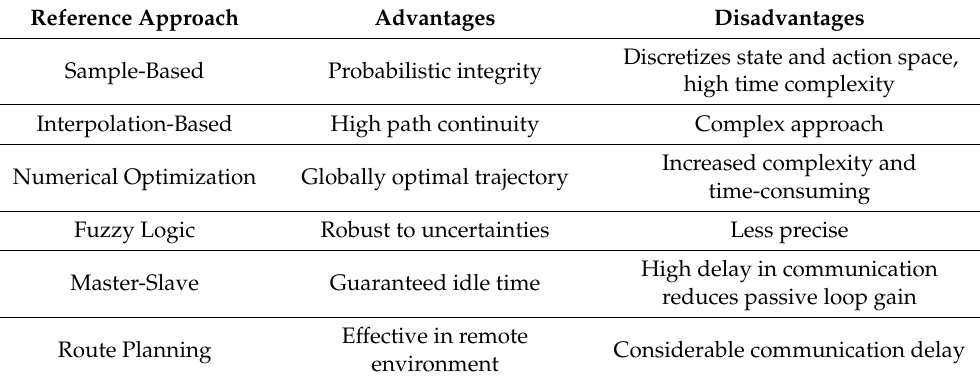
Table 1. Comparison of few above-mentioned referenced